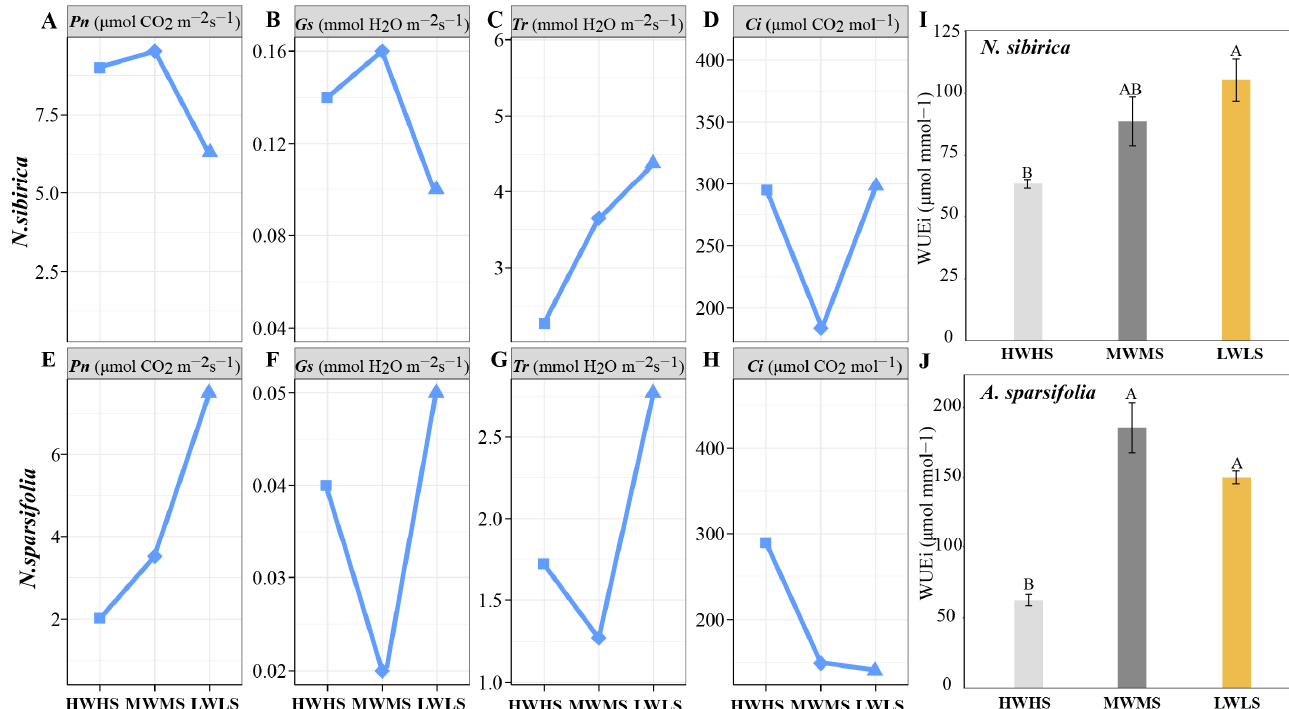
Figure 4. Changes in net photosynthetic rate ( Pn , A , E ), stomatal conductance ( Gs , B , F ), transpiration rate ( Tr , C , G ), intercellular CO 2 concentration ( Ci , D , H ), and WUEi ( I , J ) of N. sibirica and A. sparsifolia under different plots. Different capital letters (A, B) above the error bars indicate the WUEi of A. sparsifolia and N. sibirica under different plots.